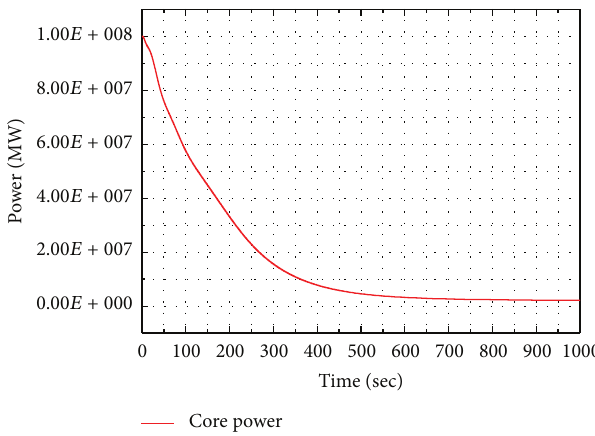
Figure 15: SNRLFR-100 core power as function of time during the ULOHS